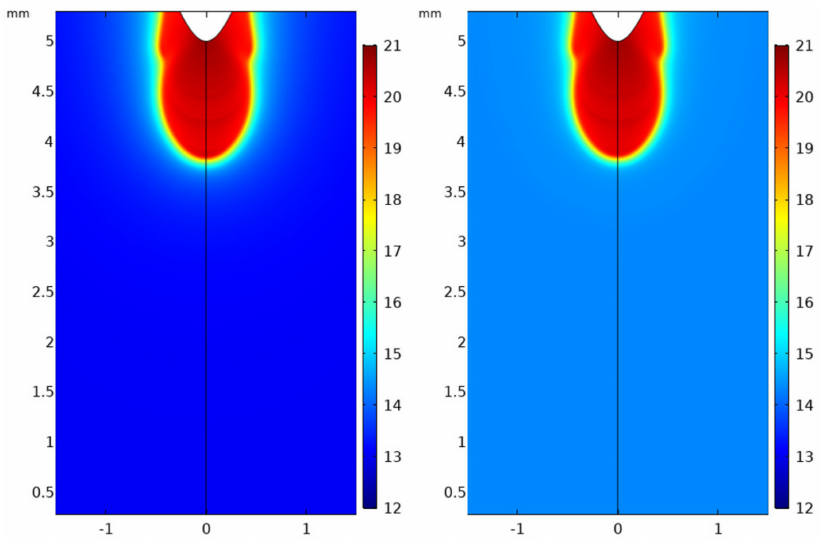
Figure 10. Surface plot of positive ion density profile ( left ) and negative ion density profile ( right ) at time 2 ns in SF 6 at atmospheric pressure. Scaling parameter: 20 on logarithmic plot represents a density value of 10 20 m − 3 .